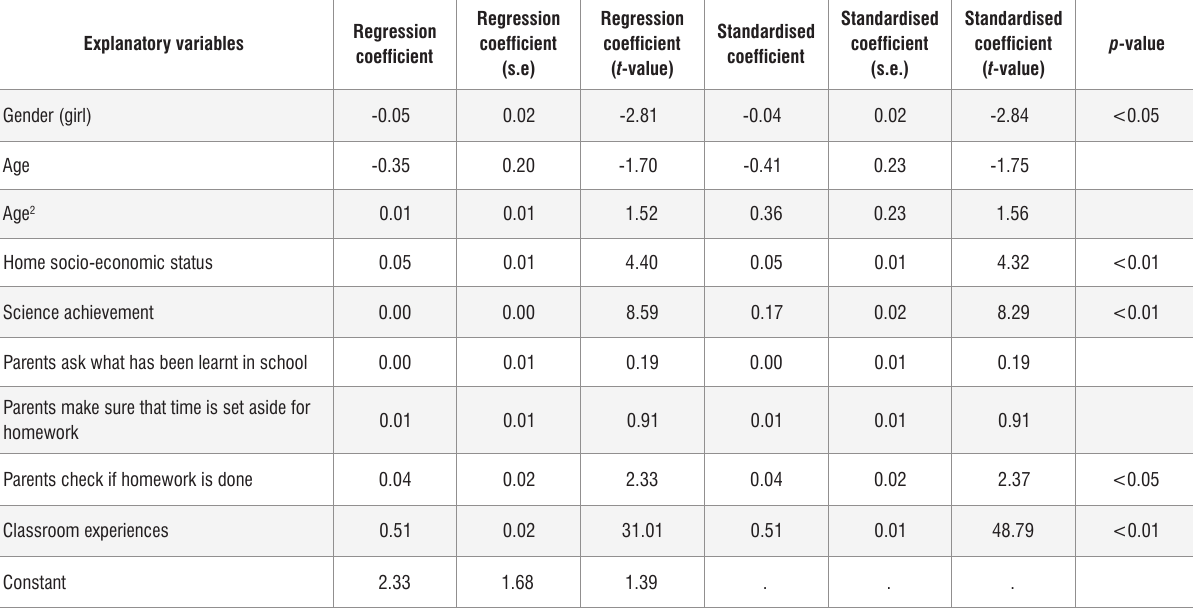
Table 3: Multiple regression results investigating the association between self-efficacy and contextual factors Explanatory variables